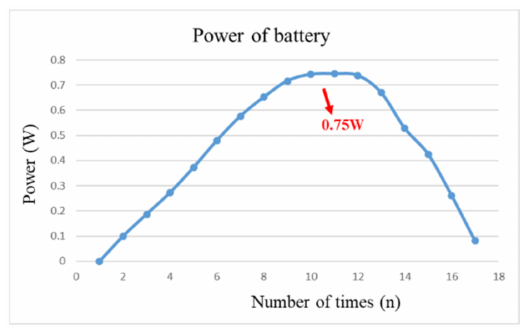
Figure 13. The power curve of